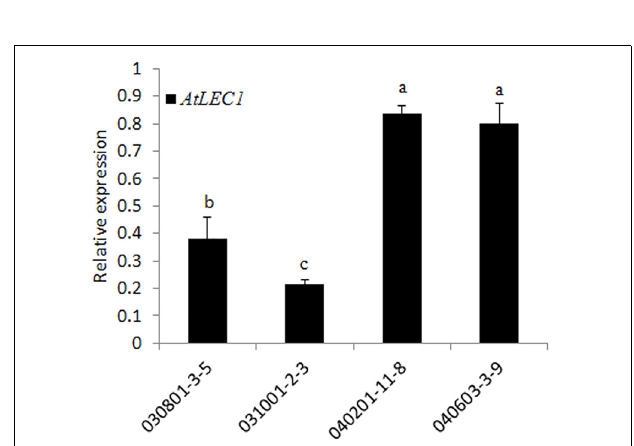
FIGURE 3 | Transcript level analysis of the foreign AtLEC1 gene in different transgenic peanut lines by qRT-PCR. One-way analysis of variance (ANOVA) for gene expression levels between different transgenic peanut lines was performed by SPSS software, and the significance of differences ( p < 0.05) was assessed by Duncan’s new multiple range test with values with different letters being significantly different.